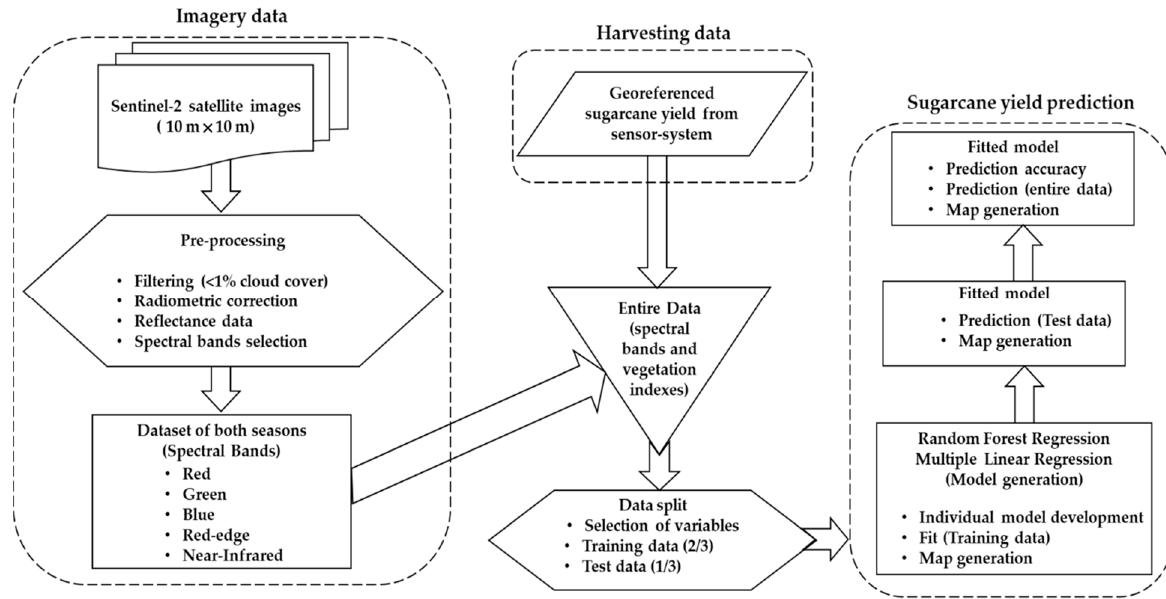
Figure 2. Flow chart of the methodology for data acquisition and processing.